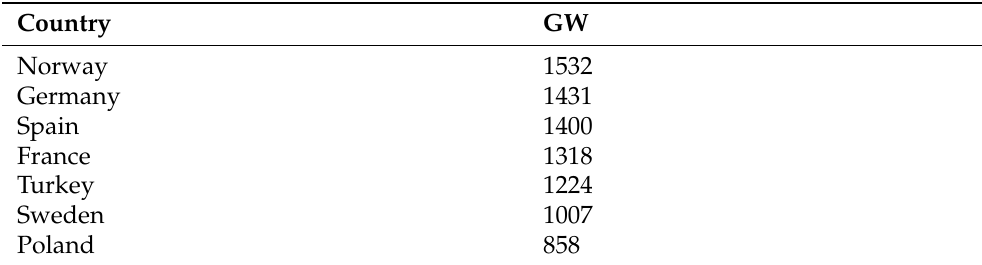
Figure 14. From the Fosen development. Wind power production is located in remote mountain areas. Norway is the country that has invested the least in wind power of the Nordic countries, but the Fosen development led Norway to the top in increased installed capacity in wind power in the year 2020. This is shown in Table 17. Table 17. Due to the Fosen project, Norway topped the list of countries with the largest wind power development in Europe in